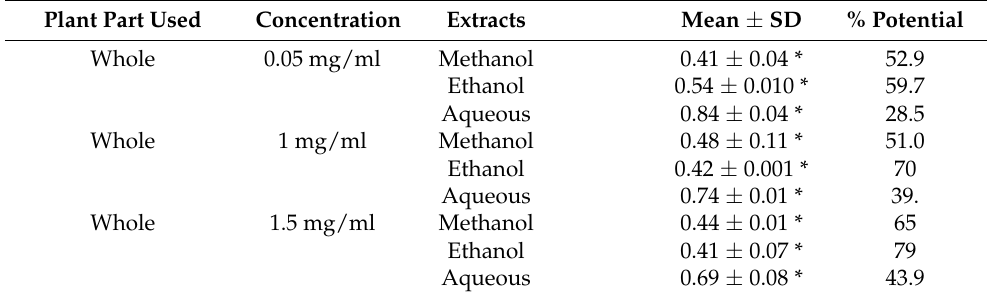
Table 7. Antioxidant activity of Polystichum lonchitis L. The mean difference was considered statisti- cally significant at the 0.05 level. Significance indicated (* p < 0.05).